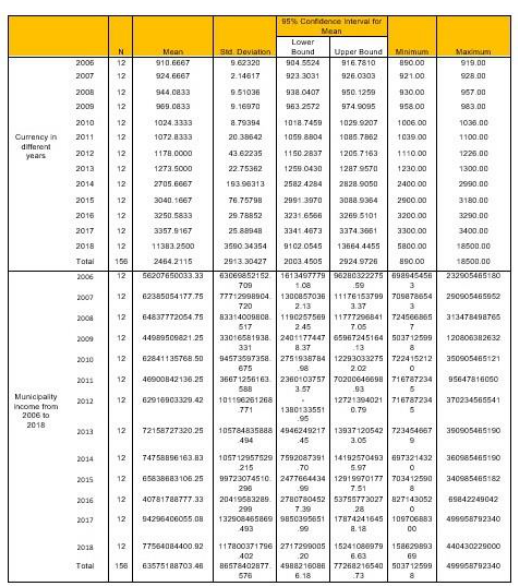
Table 2: Municipality Income and U.S. Dollars Confidence Intervention